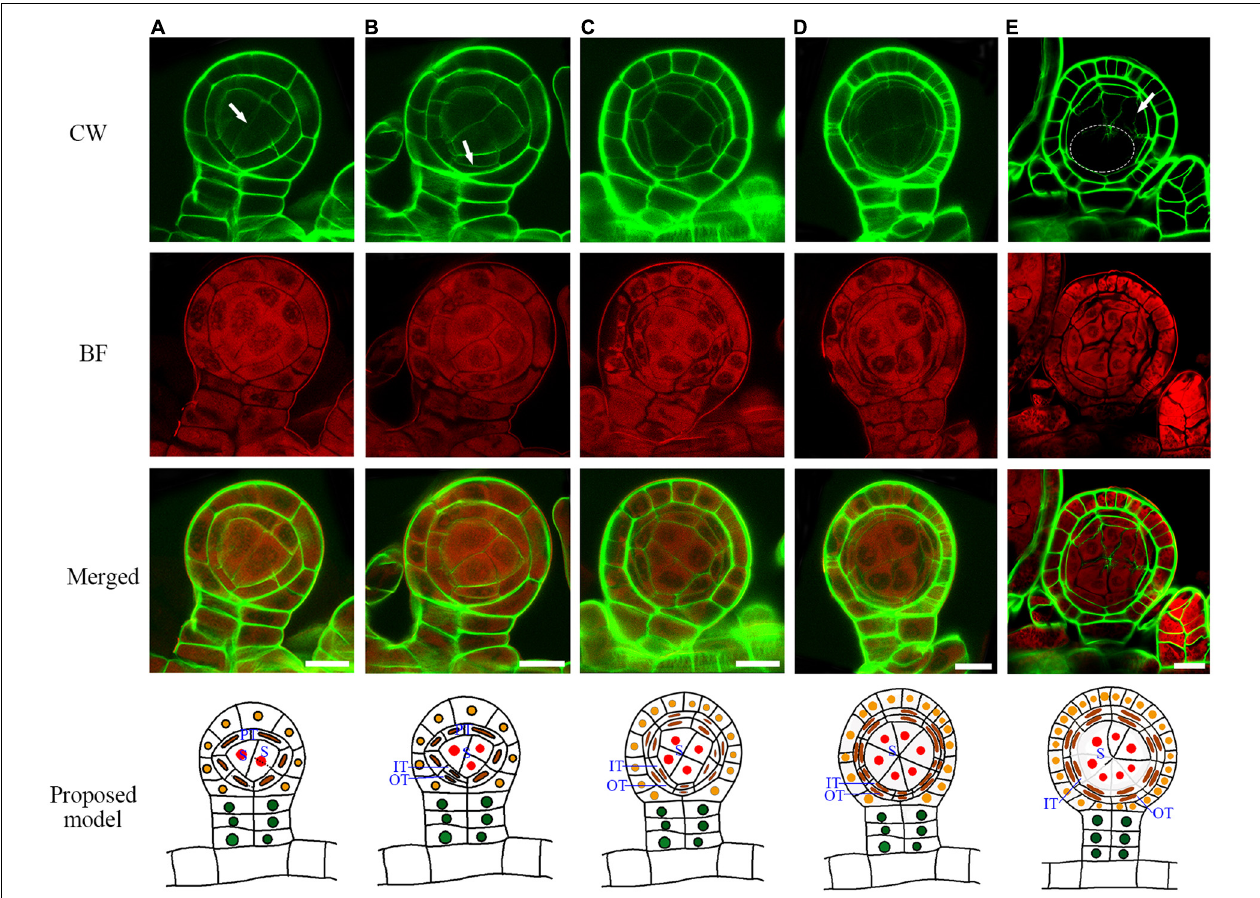
FIGURE 4 | The primary tapetum was divided into two layers by the periclinal division, and the sporogenous cells were divided four times to form sixteen spore mother cells. (A) The sporogenous cell undergoes symmetric mitosis. Arrow points to the newly formed cell wall. (B) A primary tapetum cell undergoes a periclinal division. Arrow points to the newly formed cell wall. (C) The primary tapetal layer produces two tapetal layers through periclinal divisions. (D) Two tapetal layers are formed. (E) Some cell walls among the spore mother cells and inner tapetal cells are gradually degraded. Arrow points to the degrading cell wall between a spore mother cell and inner tapetal cell. Dotted circle points to the area where the cell walls are degraded. CW signals are colored green. BF signals are colored red. Scale bar = 20 µ m. (A–E) Proposed models are shown on the right of each inset. PT, primary tapetum cell; IT, inner tapetum cell; OT, outer tapetum cell; S, sporogenous